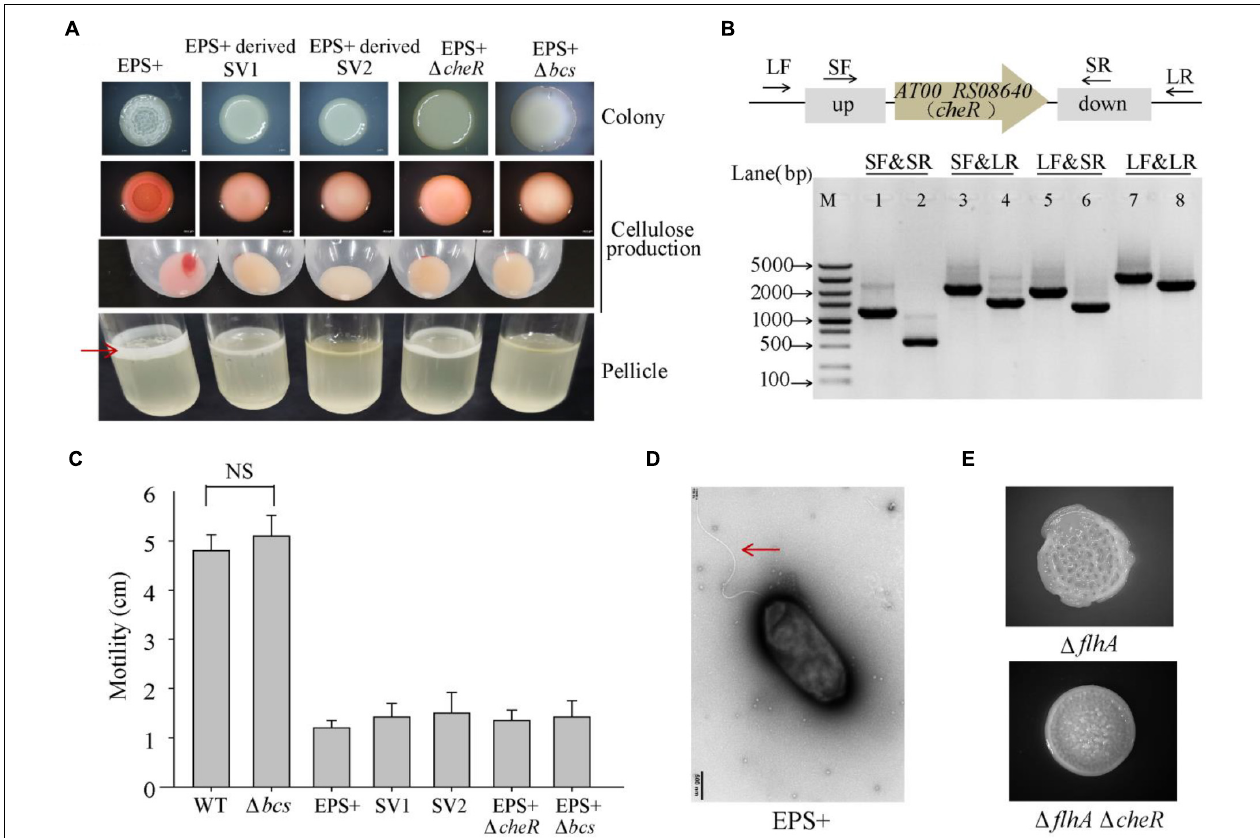
FIGURE 5 | Spontaneous mutations in cheR or bcsC suppress the wrinkled colony morphology of the P. lipolytica EPS+ strain. (A) The colony morphologies, cellulose production, and pellicle formation of the P. lipolytica EPS+ strain, two suppressor strains and two gene deletion mutant strains of the EPS+ variant. Red arrow indicates bacterial pellicle formed in air-liquid interface after 5 days of incubation. (B) In-frame deletion of cheR in P. lipolytica EPS+ was confirmed by PCR using four primer sets flanking the open reading frame of cheR (up panel). M indicated marker. Lanes 1, 3, 5 and 7 used DNA from the wild-type strain, and lanes 2, 4, 6 and 8 used DNA from the cheR mutant strain. (C) Swimming motility of the indicated strains after 24 h of incubation. (D) Morphology of the P. lipolytica EPS+ strain examined by transmission electron microscopy. Arrow indicates flagellar. (E) The colony morphologies of the (cid:49) flhA and (cid:49) flhA (cid:49) cheR double deletion mutant